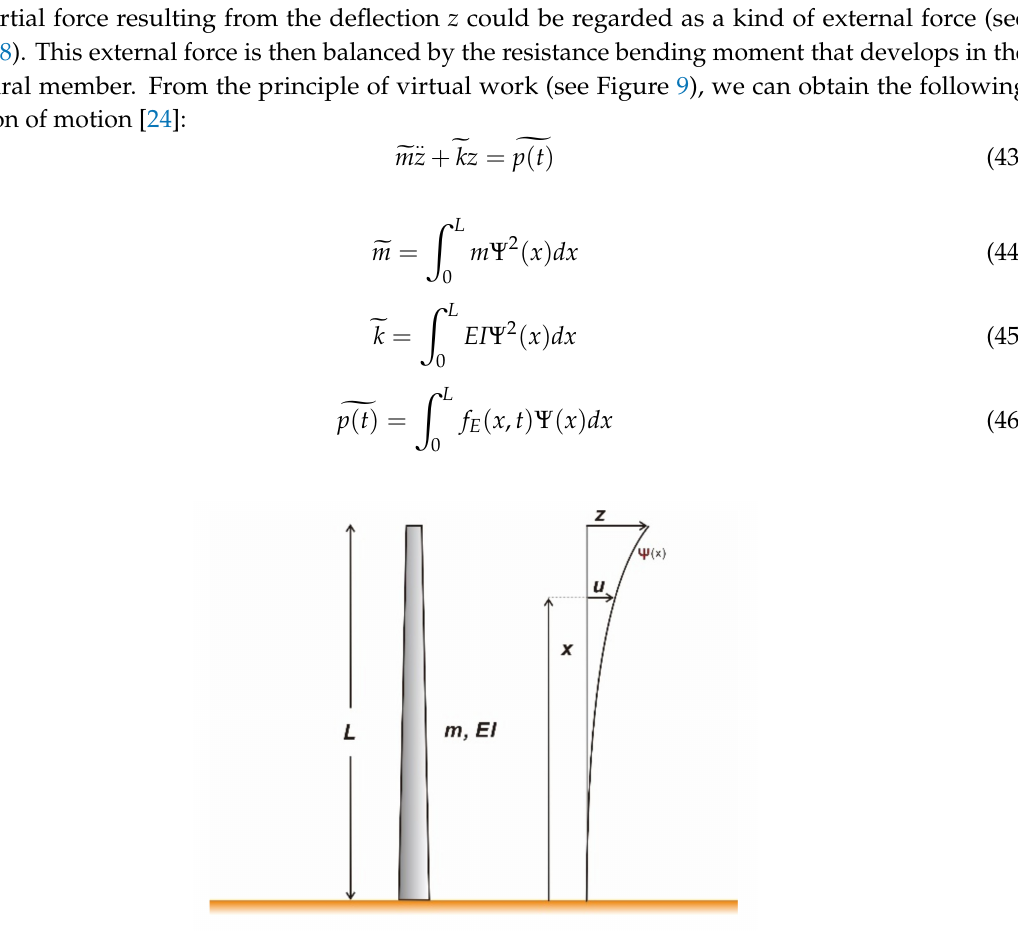
Figure 8. Definition sketch of the o ff shore wind energy converter and the coordinate